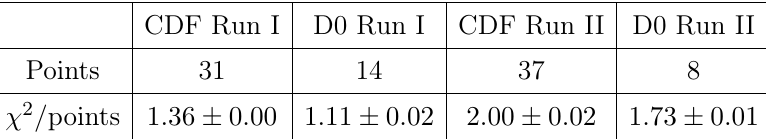
Table 9 . Number of points analyzed and (cid:31) 2 values for Z boson production at